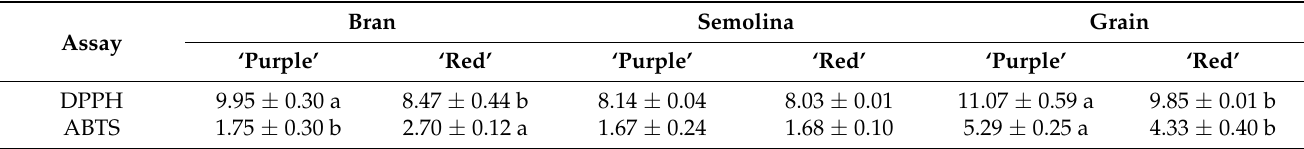
Table 7. Antioxidant activity ( µ mol Trolox equivalent/g DM) in ‘Purple’ and ‘Red’ landraces. Values are reported as mean ± SD ( n = 5). Significant differences between the two varieties for bran, semolina, or grain are indicated by lowercase letters ( t -test, p <